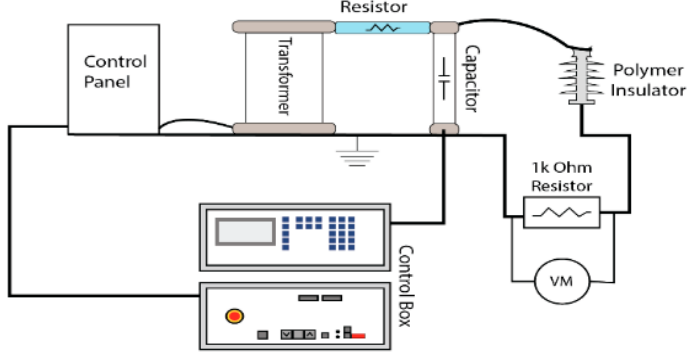
Figure 5. Schematic of insulator leakage current test.